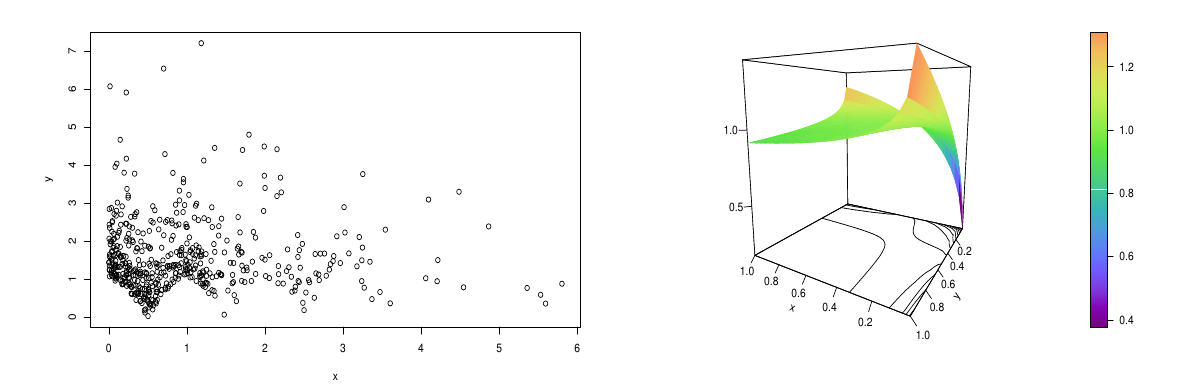
Figure 6. Scatter plot of the data ( left ) and plot of the estimated IP copula density ( right ).